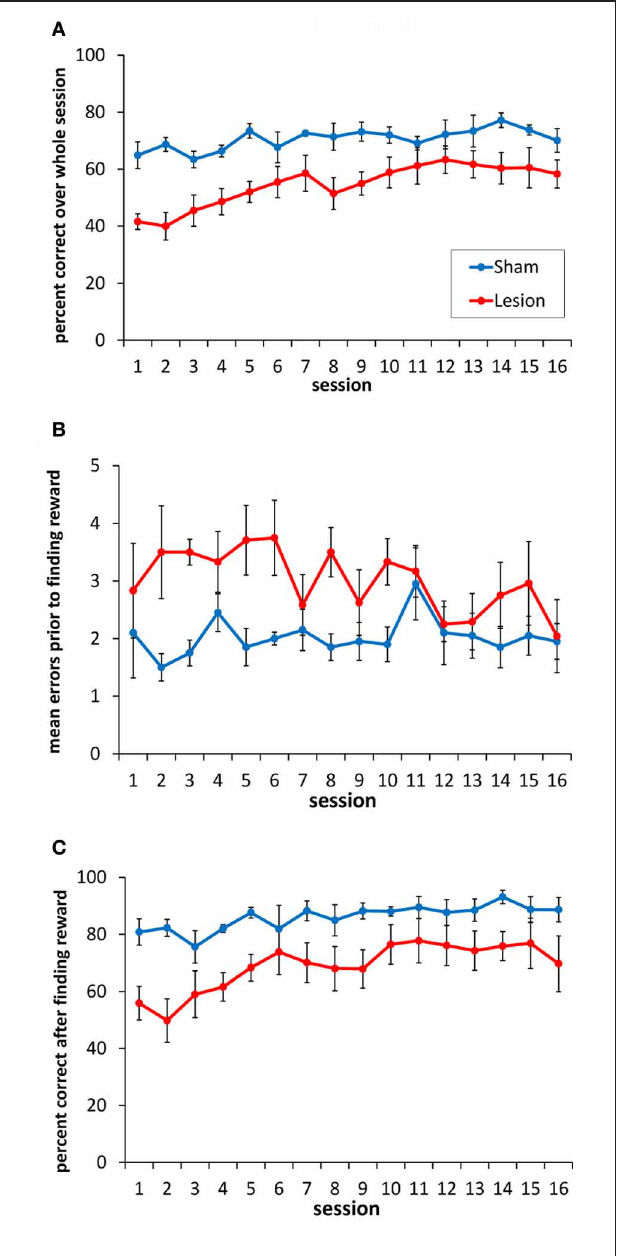
FIGURE 4 | Performance of the sham-lesioned and hippocampus-lesioned animals on the double Y-maze task. (A) Animals with hippocampus damage exhibited a consistent impairment in the accuracy of their goal box choices compared to the sham-lesioned animals. (B) Animals with hippocampus damage made more errors (non-rewarded box choices) before choosing the rewarded location, compared to the sham-lesioned animals. (C) Animals with hippocampus damage made more errors than sham-lesioned animals after the reward location had been found in each block of